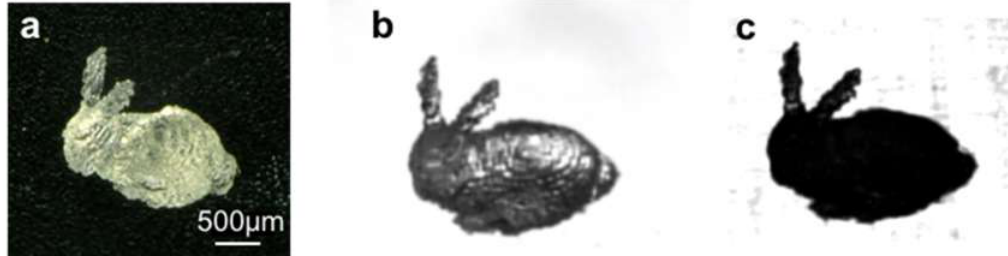
Figure 4. Comparison of silhouette images of a 3D printed bunny model using visible and UV light. ( a ) optical microscope image of an epoxy-based resin model of a bunny, produced using micro-stereolithography; ( b ) silhouette image obtained with visible transmitted light; and, ( c ) silhouette image obtained with UV transmitted light.